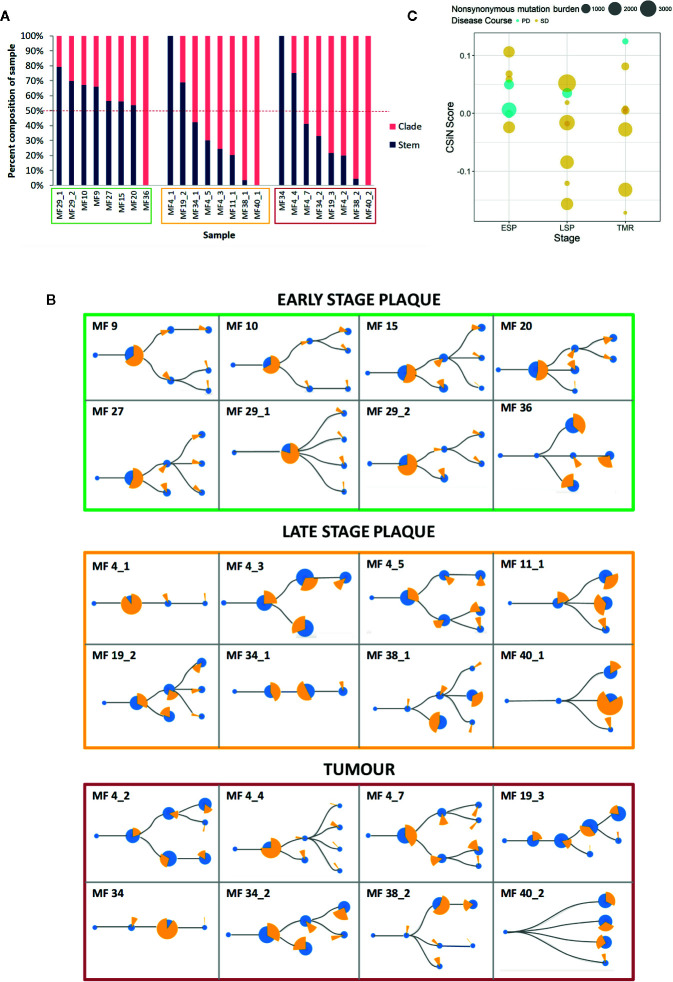
Clonality of neoantigens in mycosis fungoides (MF). (A) Proportion of stem and clade missense mutations producing putative neoantigens. Sample codes are enclosed in boxes with colors corresponding to the lesion type - early stage plaque (green), late stage plaque (yellow) and tumor (red). The dashed red line represents the 50% mark that distinguishes whether the majority of the sample is composed of stem or clade neoantigens. Early stage plaques have a greater proportion of stem mutations producing neoantigens compared to late stage plaques and tumors where more clade mutations produce neoantigens. (B) Phylogenetic trees with putative neoantigen analysis. The size of the blue circles represents the proportion of missense mutations that comprise each node. ‘Stem’ nodes are those present prior to branching which then produces ‘clade’ nodes. The yellow pie chart in whole represents all neoantigens from the sample. Each slice of the pie chart represents the proportion of neoantigens originating from a node. With advancing disease stage, a greater proportion of neoantigens originate from clade mutations. (C) Cauchy-Schwarz index of Neoantigens (CSiN) scores of MF samples. The bubble plot shows individual CSiN scores and the number of non-synonymous mutations in ESP, LSP and TMR samples. Samples from patients who progressed in disease stage are colored in blue. Median CSiN scores are: ESP (0.027822, n=8), LSP (−0.01709, n=8) and TMR (0.004234, n=8).